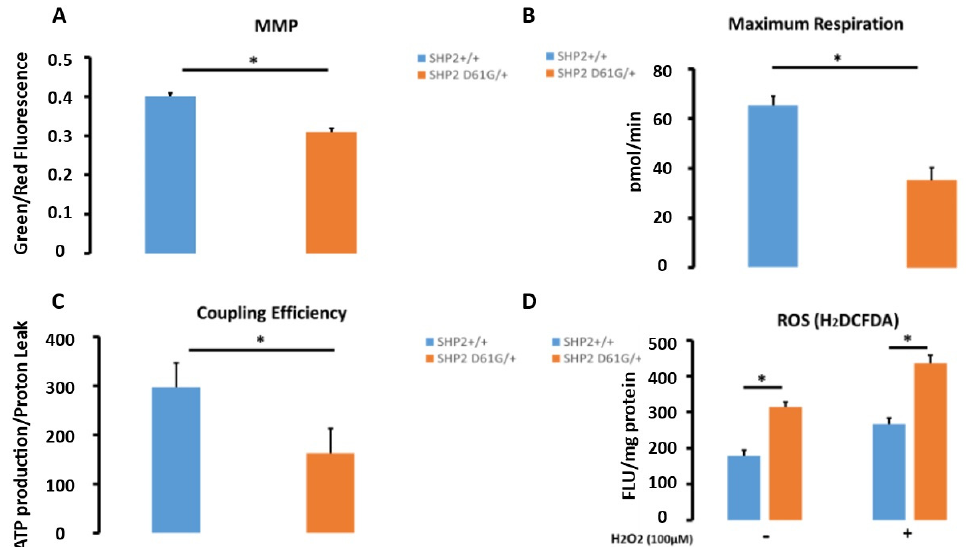
Figure 3. SHP2 D61G/+ constitutively active mutant MLFs exhibit impaired mitochondrial function with increased ROS production. Figure presents ( A ) Mitochondrial function of SHP2 D61G/+ , ( B ) Maximum respiration, (pmol/min), ( C ) Coupling efficiency (ATP production/proton leak), and ( D ) Reactive oxygen species (ROS). Compared to wild-type ones, D61G cells show a 1.6-fold increased fluorescence, indicating significantly increased ROS levels. Note that SHP2 D61G/+ constitutively active MLFs were characterized by reduced MMP levels (1.3-fold), maximum respiration (oxygen consumption rate) (1.86-fold), and coupling efficiency (1.9-fold), indicating ineffective mitochondrial metabolism potentially resulting in increased ROS (1.6-fold) compared to wild-type ones. Data are presented as bar graphs with horizontal bars representing mean mitochondrial membrane potential (MMP) levels (green/red fluorescence ratio) ± SEM of 6 samples (biological replicates). Independent samples Student(cid:31)s t -test, * p < 0.05. Details for this fi gure are presented in Supplemental Data S3.